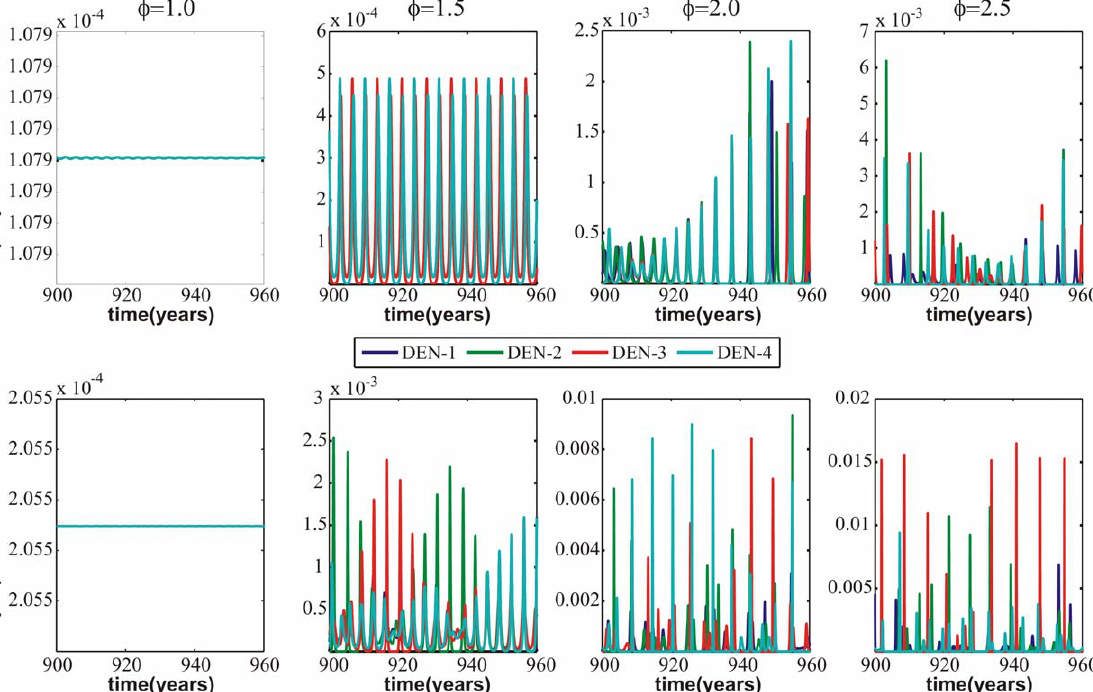
Figure 2. General model dynamics under parameter changes. Here we observe the fluctuations in the total proportion of the population that has been infected by each serotype against time for different levels of transmissibility enhancement w (from left to right: w ~ 1 : 0 , w ~ 1 : 5 , w ~ 2 : 0 , w ~ 2 : 5 ; no enhancement is represented by w ~ 1 : 0 ; increasing w corresponds to augmented levels of enhancement). The top panel is for the model with the assumption of total immunity after two infections only (model (i)) whilst the bottom is for the model which allows for infection with all four serotypes (model (ii)). The individual serotype dynamics seem to become ever more desynchronised as w increases in both models, though this effect appears stronger in model